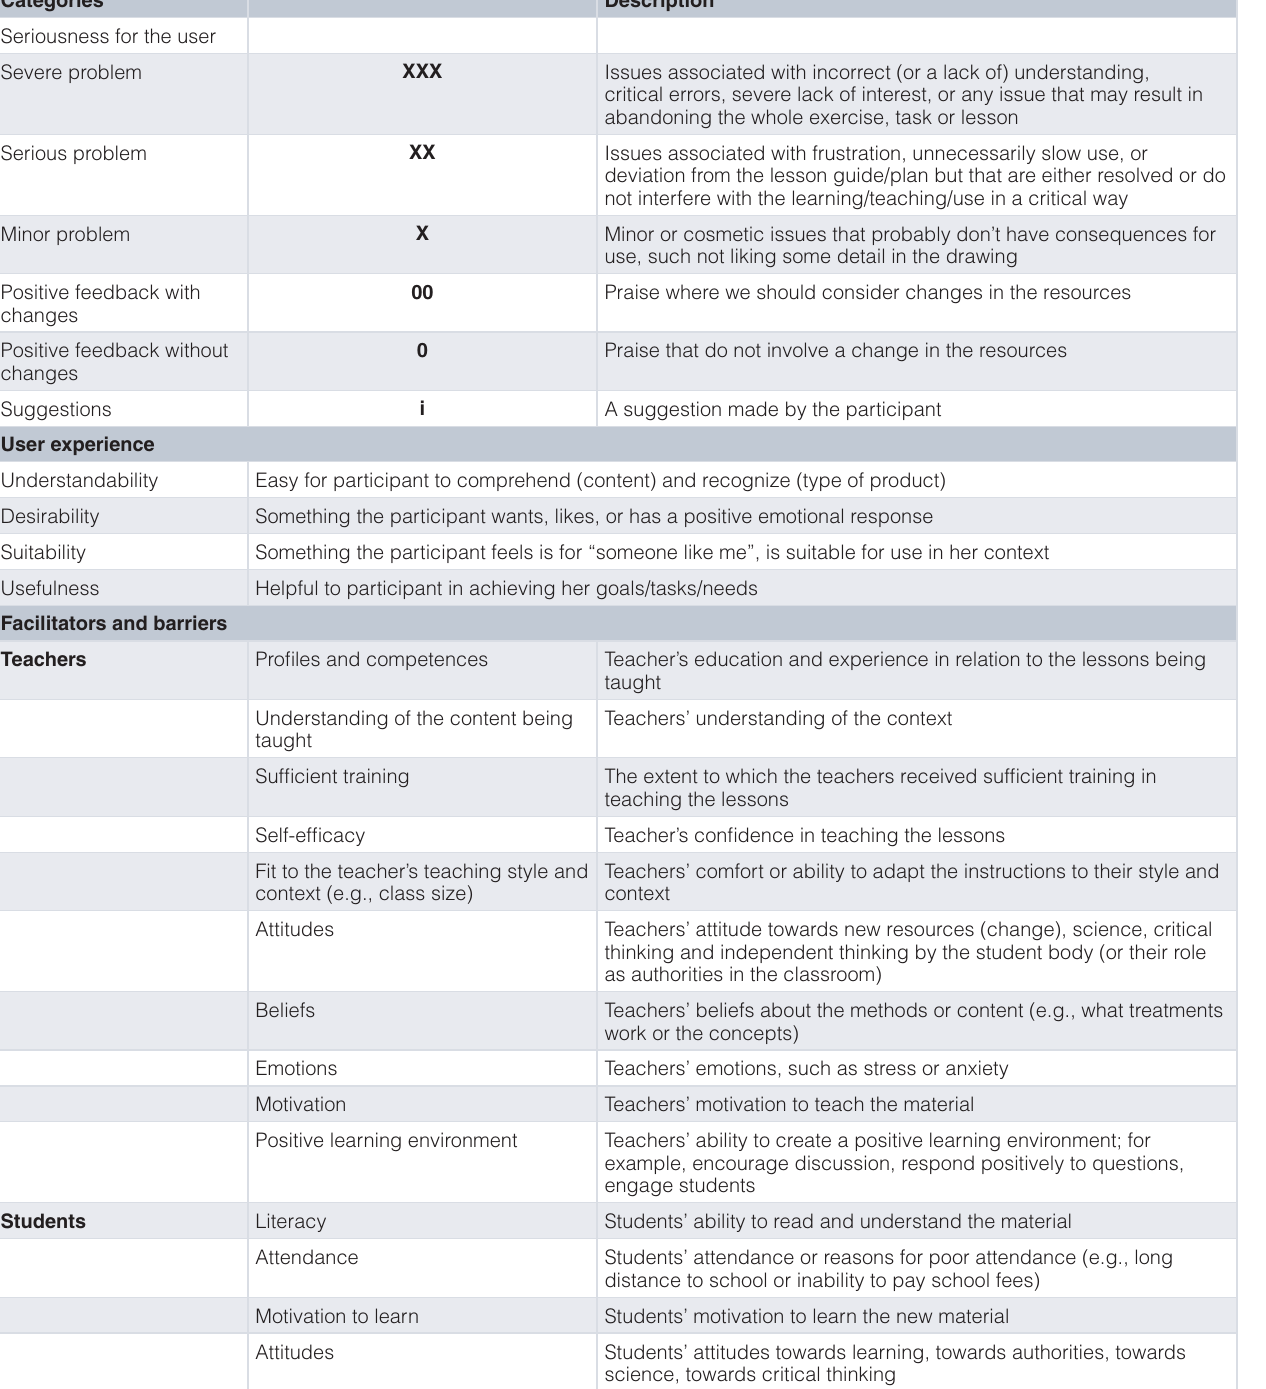
Table 4. Categories of the qualitative analysis for the pilot study 28,34 . Categories